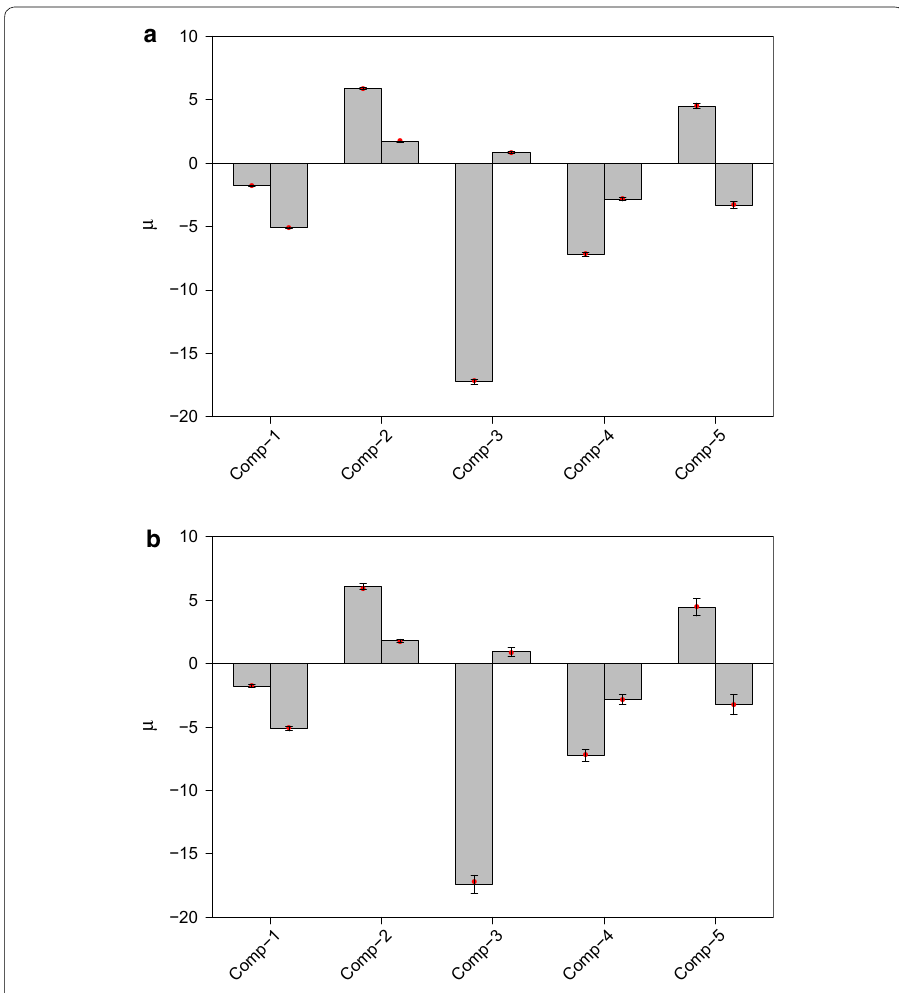
Fig. 2 Posterior estimates of the components mean vectors, for the data shown in Fig. 1, conditional on a the full 5000 observations and b the 500 quantized values. The error bars indicate points show the true